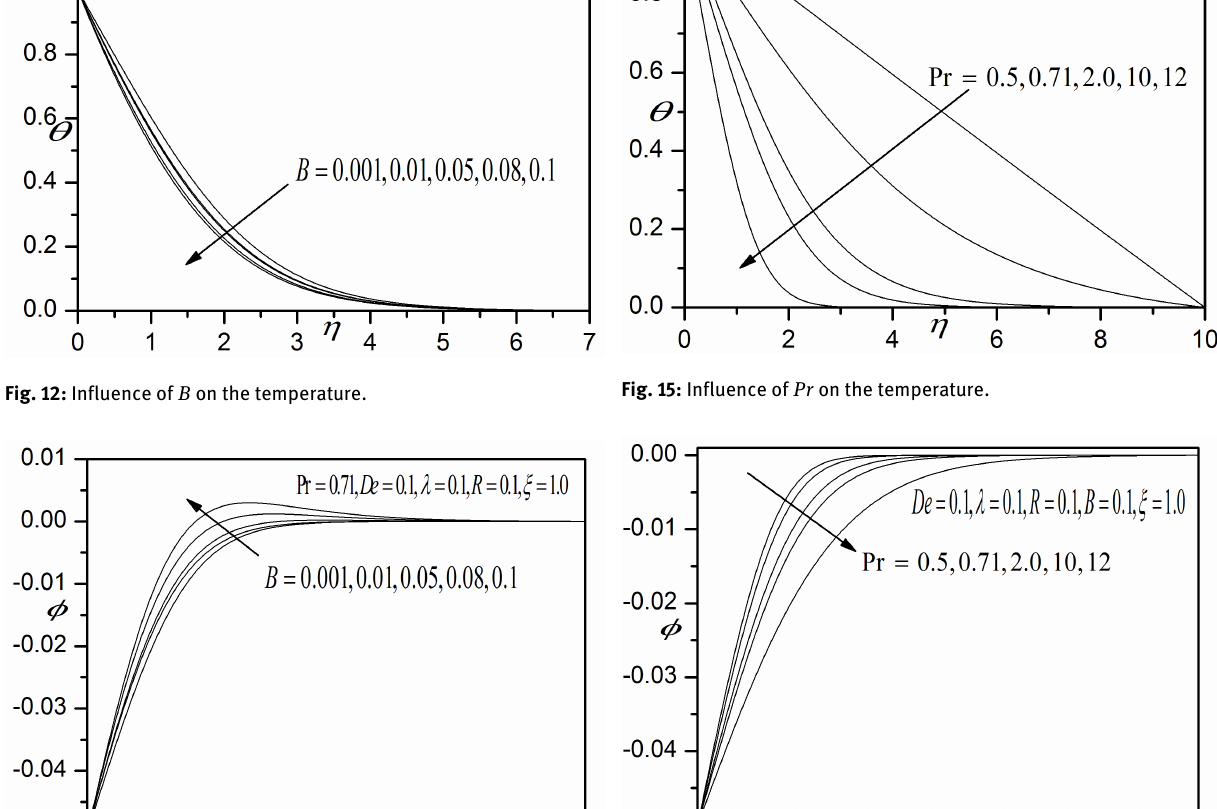
Fig. 13: Influence of B on the angular velocity.